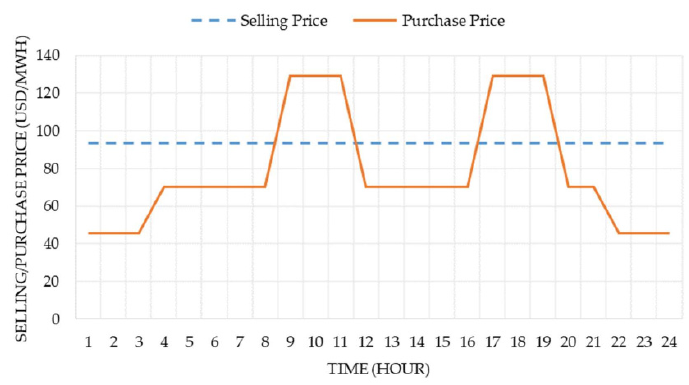
Figure 3. The selling/buying price in the DA market.